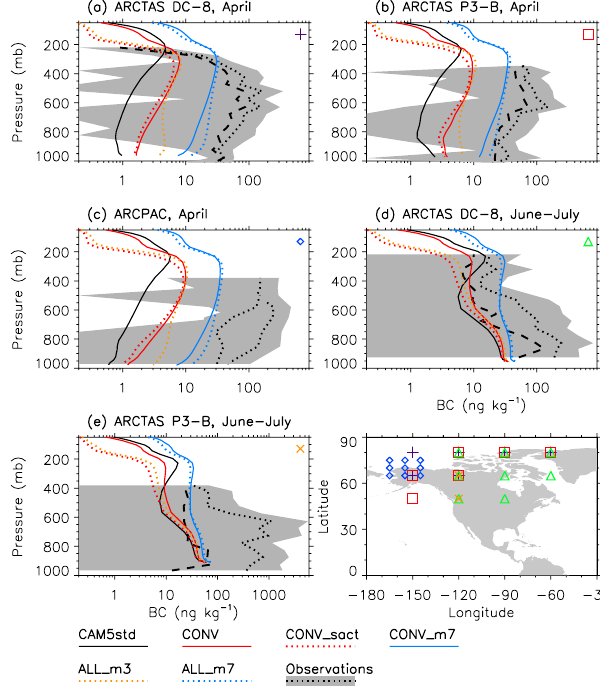
Fig. 8. Same as Fig. 7 but for the high latitudes over North America. In (c) , the higher BC mixing-ratio profile (ngkg − 1 ) is for flights that sampled episodic biomass burning plumes, and the lower mixing- ratio profile is for aged Arctic air. The mean profiles in (d) and (e) were also affected by summer smoke